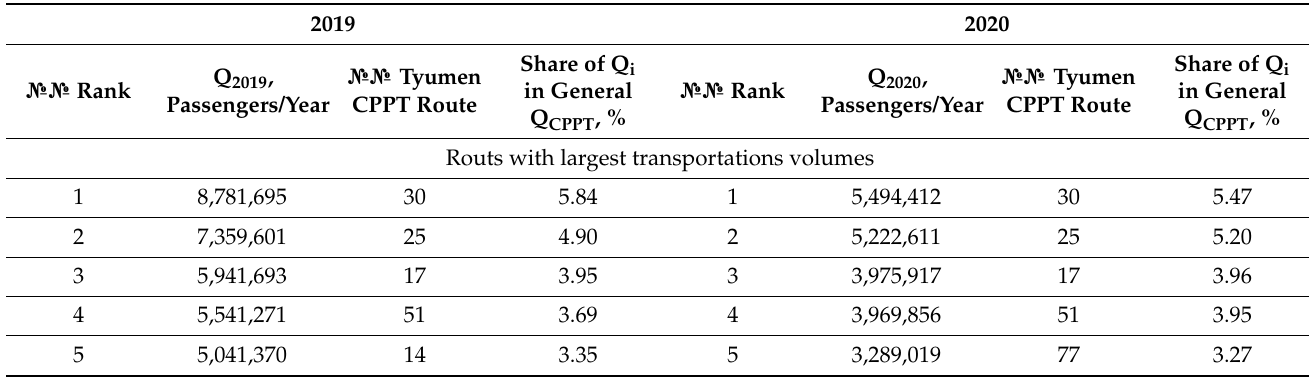
Table 7. Example of ranking of annual transportation volumes on Tyumen CPPT routes in 2019 and